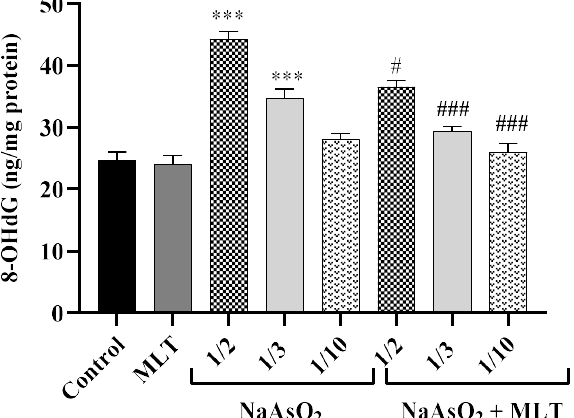
Figure 3. Assessment of 8-hydroxy-2-deoxyguanosine Abbreviations: 8OHdG: 8-hydroxy-2-deoxyguanosine; MLT; melatonin, NaAsO 2 ; sodium arsenite; Results are expressed as mean ± SEM for five animals in each group (n = 5). *** p < 0.0001 (Vs. control or melatonin) ### p < 0.0001; # p < 0.05 (Vs. ½ LD50 NaAsO 2 ).